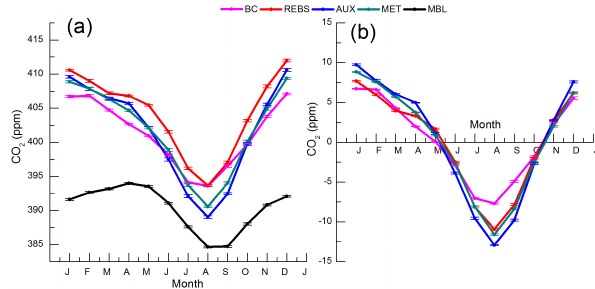
Figure 5. (a) Variations of monthly CO 2 mole fractions in the four methods, also compared to the surface values at similar latitudes (30 ◦ N) from the MBL reference (MBL, 2015). The data in this fig- ure are values smoothed by the curve-fitting method of Thoning et al. (1989). (b) The detrended seasonal CO 2 cycles in the four meth- ods. This is the smoothed curve minus the trend. Error bars indicate confidence intervals of